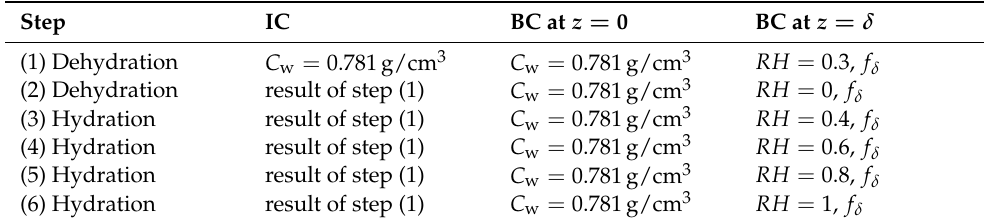
0.01 Table 3. Initial conditions (IC) and boundary conditions (BC) used to evaluate the water concen- tration in the SC. The inner boundary is connected to the epidermis and is assumed to always be fully hydrated C w = 0.781g/cm 3 . The initial conditions for the hydration steps are the resulting equilibrium of the first step to simulate normally hydrated skin. During all steps, the skin is exposed to air. Therefore, the flux f δ is dependent on the ambient relative humidity according to